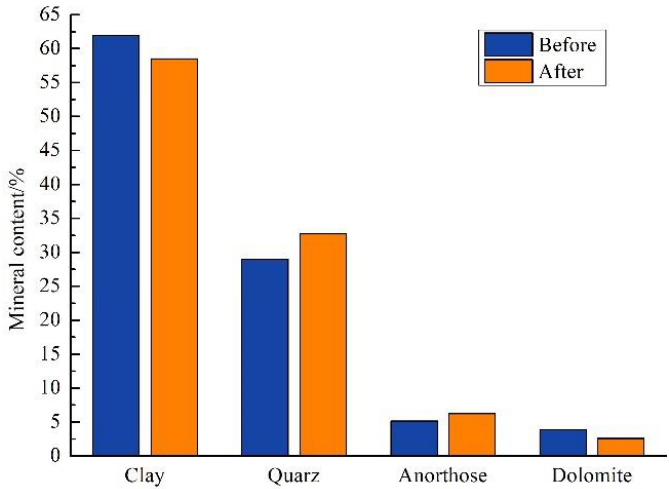
Figure 4. Whole rock analysis diagram.